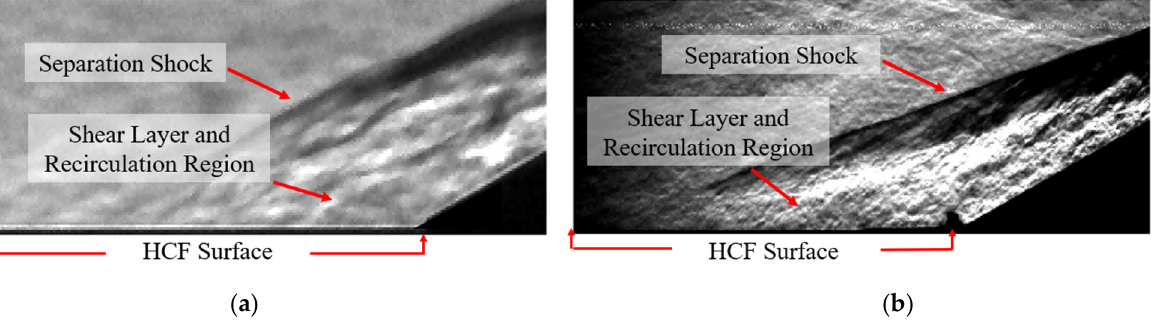
Figure 5. Representative schlieren images, ( a ) smooth surface, and ( b ) rough surface. The pixel-intensity standard deviation (r.m.s.) fields for the smooth and rough